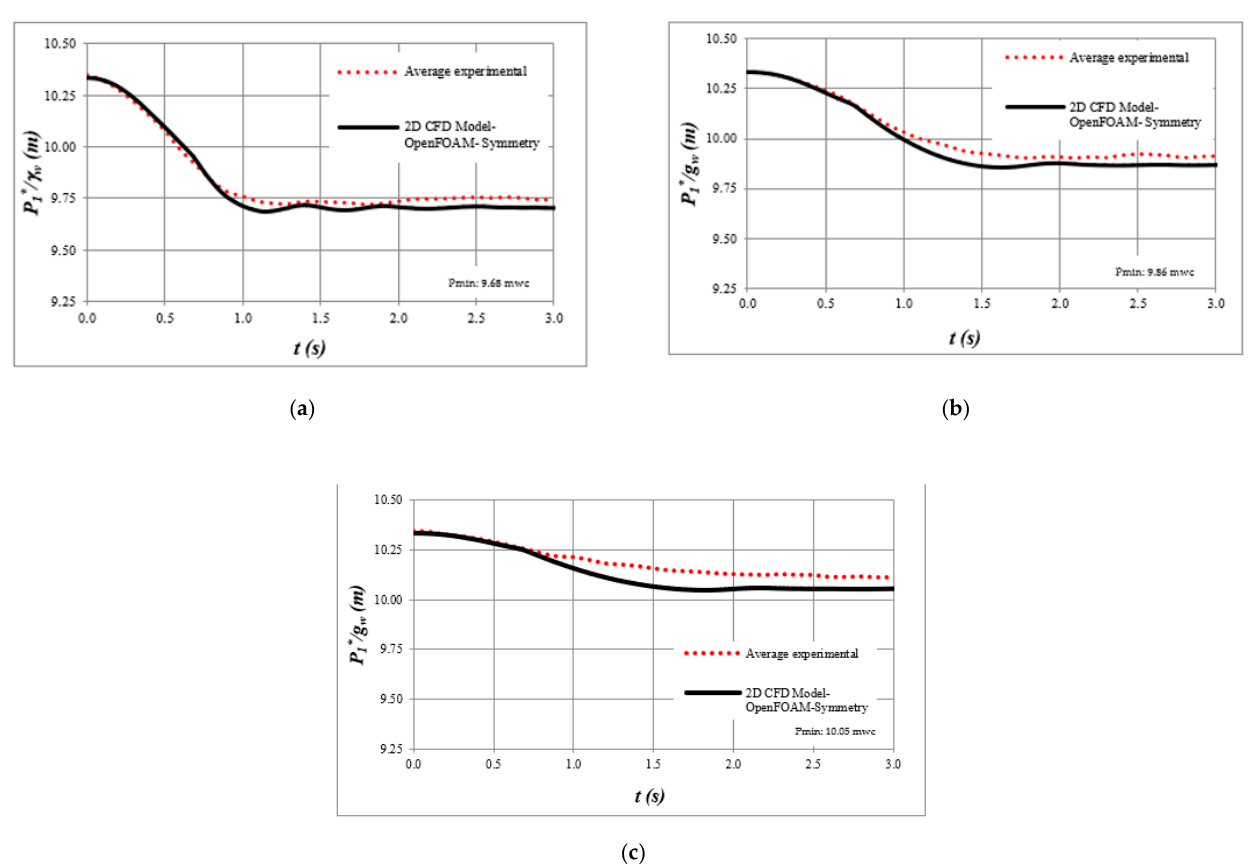
Figure 3. Comparison of pressure patterns between the experimental model and the 2D CFD OpenFOAM symmetry model for cases A: ( a ) run A1; ( b ) run A2; ( c ) run A3.